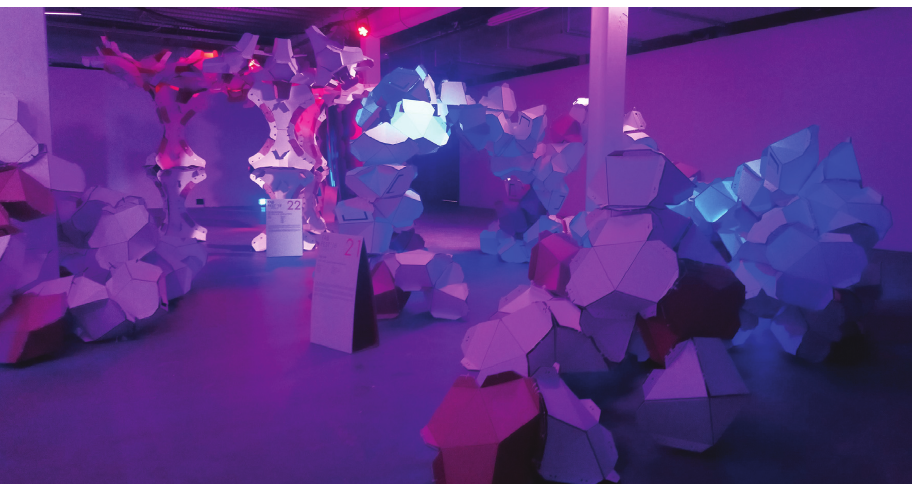
Figure 3: Two proto-architectural interventions built on-site based on collaborative design strategies: top-down design process and bottom- up on-site